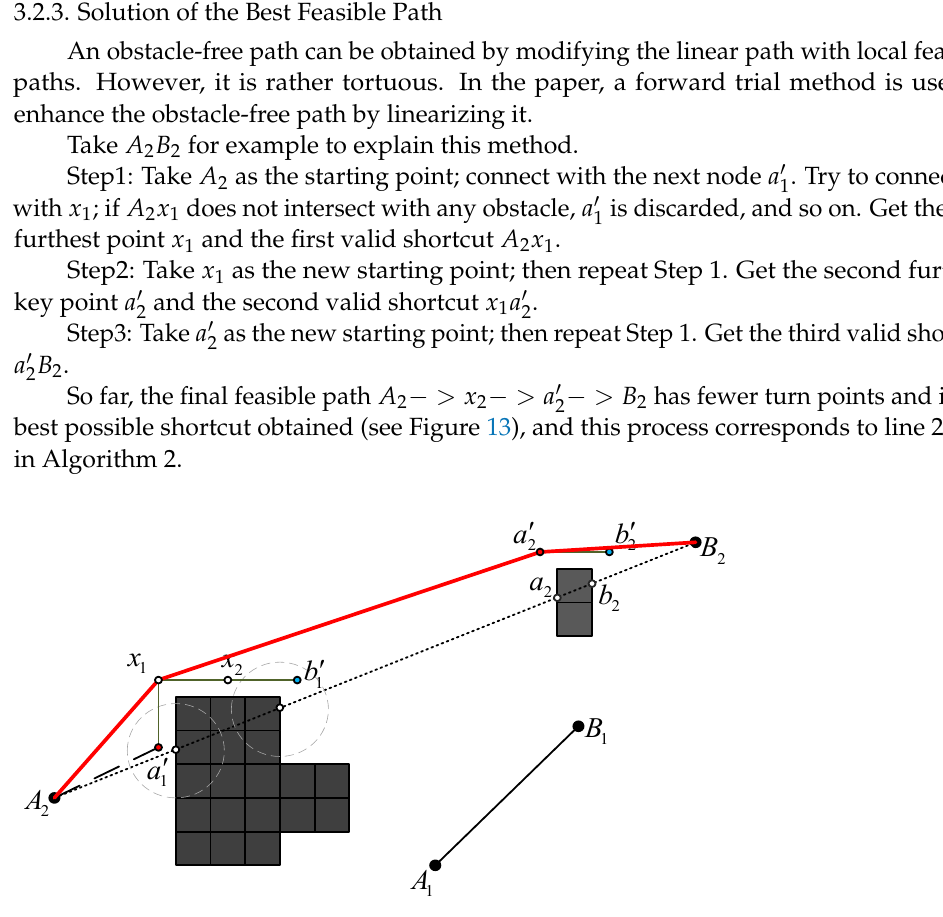
Figure 13. Schematic of the final feasible path. Algorithm 2: Path Planning Strategy under Linear Guidance